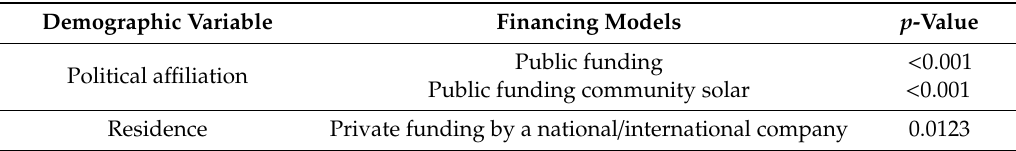
Table 4. Comparison of Means for Financing